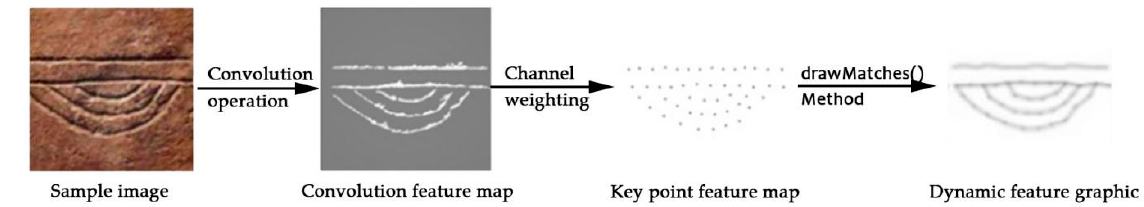
Figure 4. Feature graphic generation process by deep learning algorithms.